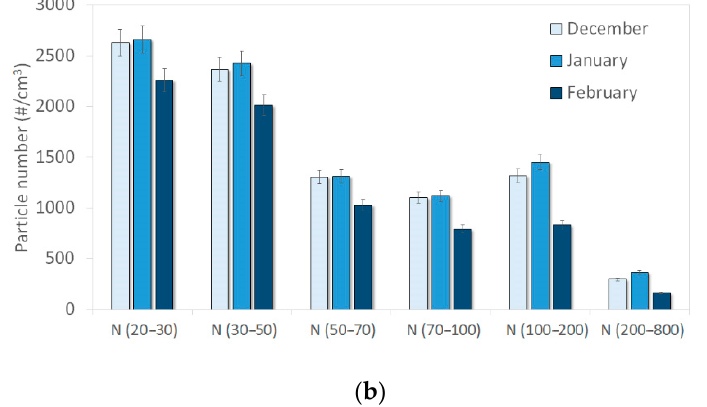
Figure 3. Monthly variation of particle number concentrations at ( a ) the background site (Strasbourg- Danube) and ( b ) the roadside site (Strasbourg-Clemenceau).